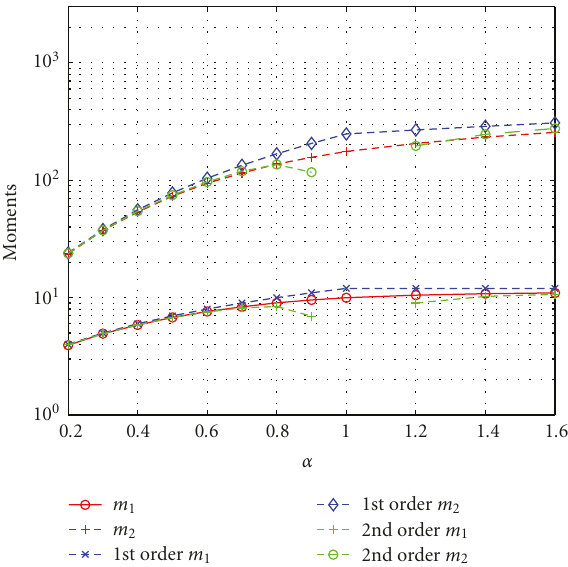
Figure 3: Comparison of di ff erent orders of approximation.